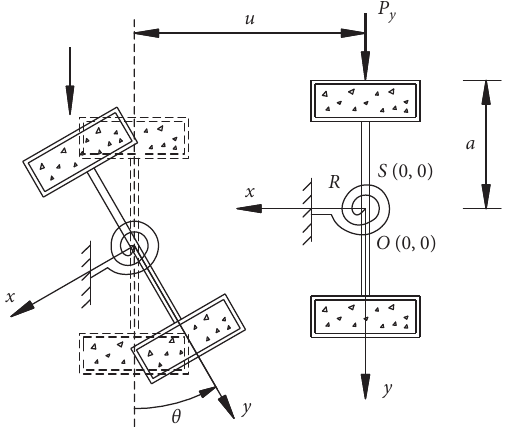
Figure 5: Lateral-torsional deformation of simply supported CFTFGS with torsional bracing.